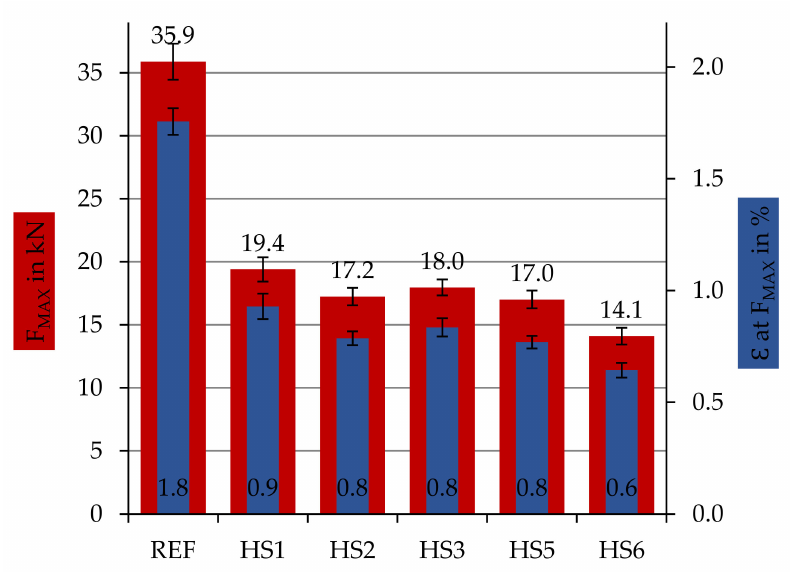
Figure 10. Specific tensile values of damaged samples repaired with UD patch material and different repair resin systems HA1-HS6 in comparison to the reference samples without any